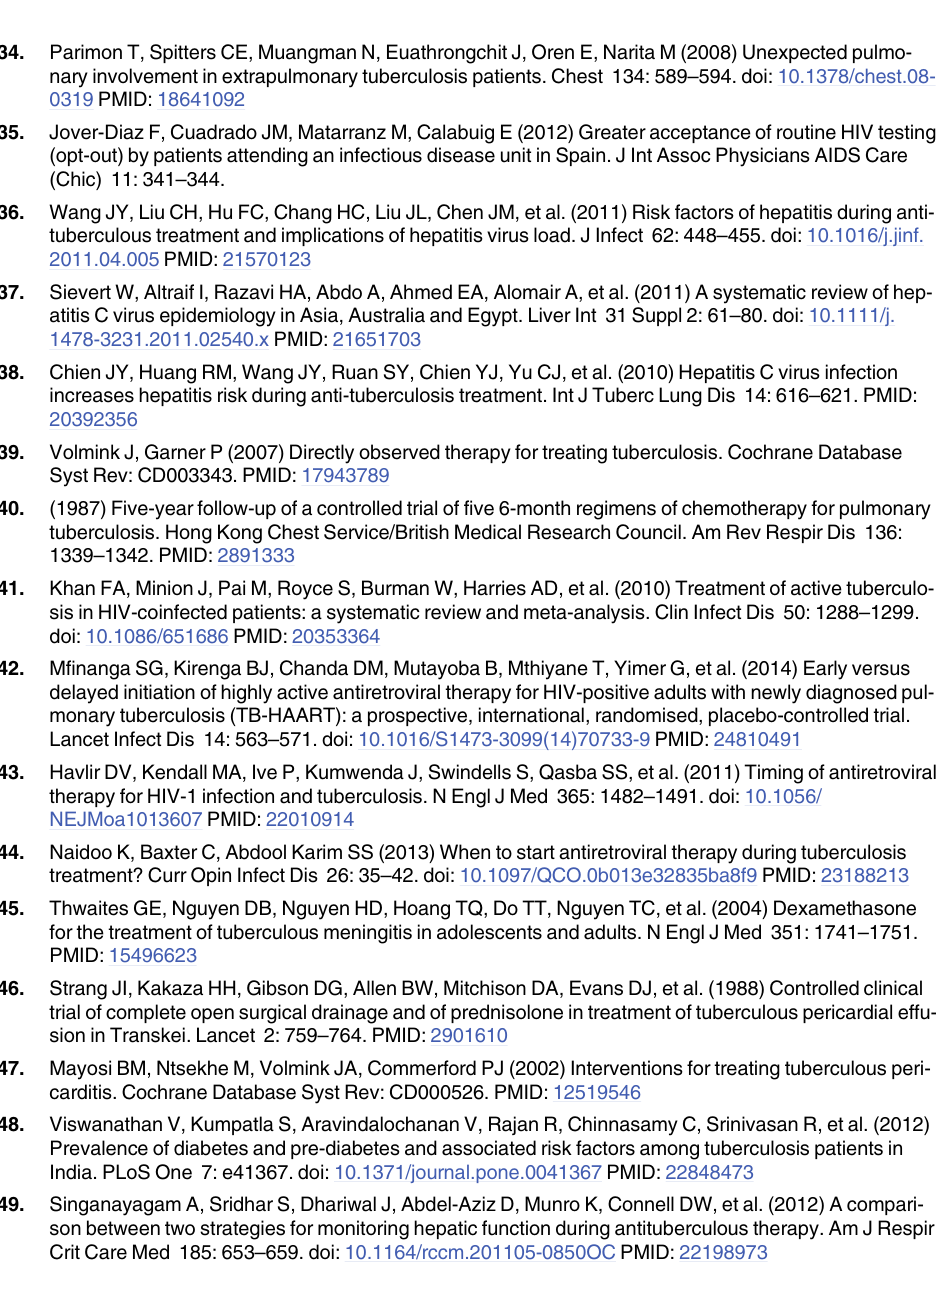
PLOS ONE | DOI:10.1371/journal.pone.0149372 March 10,